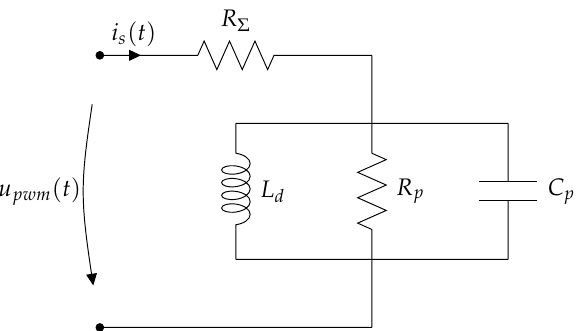
Figure 2. Reduced electrical equivalent circuit in case of a reluctance-based actuator which is driven by a PWM voltage.